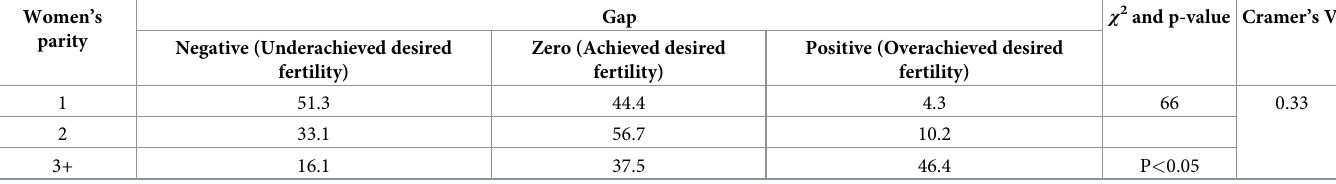
Table 7. The gap between desired number of children and expected number of children by women’s